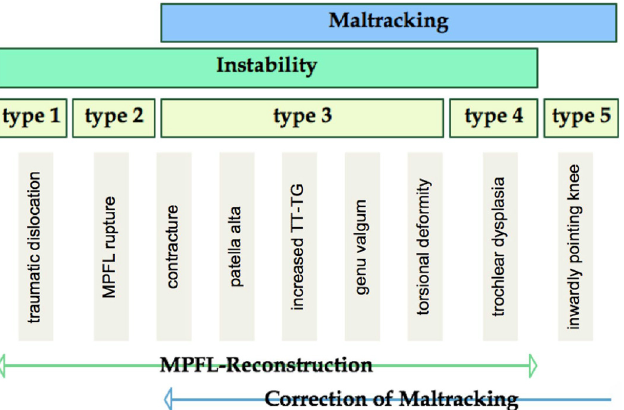
Figure 1. Algorithmic approach for the treatment of patellofemoral instabilities with or without patellar maltracking according to Frings et al. [26]. While isolated patellofemoral instabilities without patellar maltracking can be addressed by soft-tissue stabilizing techniques, a concomitant patellar maltracking requires additional diagnostic and therapeutic measures. Although closely connected, patellar instability and patellar maltracking should therefore be understood and treated as separate conditions. Adapted with permission from Ref. [26]. Copyright 2018 Springer Nature. Reprinted with